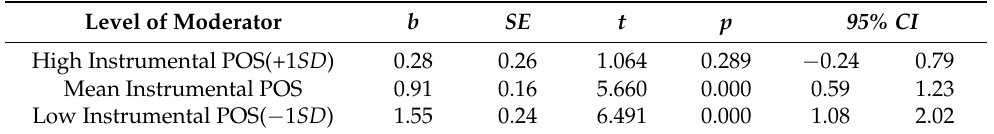
Table 4. Simple slope test of perceived instrumental support in working environmental risk per- ception and occupational strain.